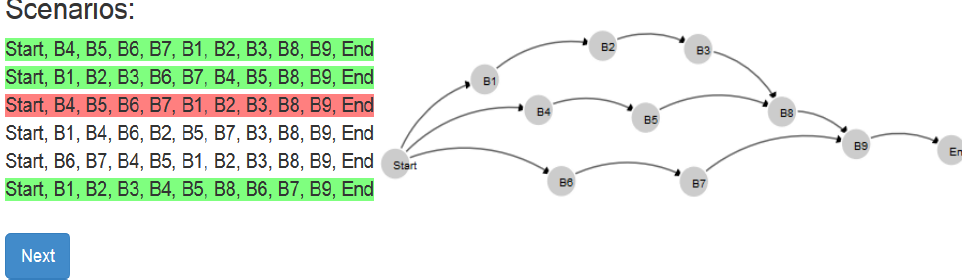
Figure 11. The last performed scenario led to the discovery of a new candidate model.